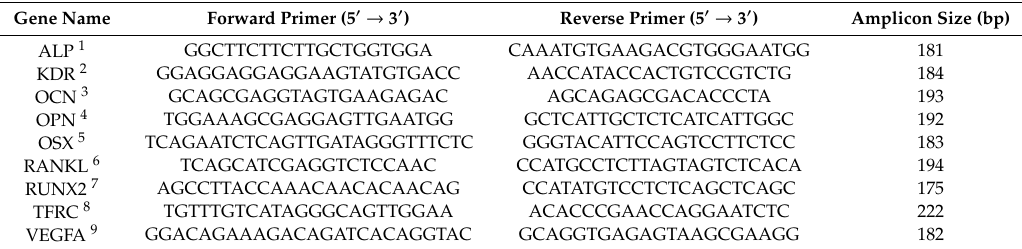
Table 1. Human primer